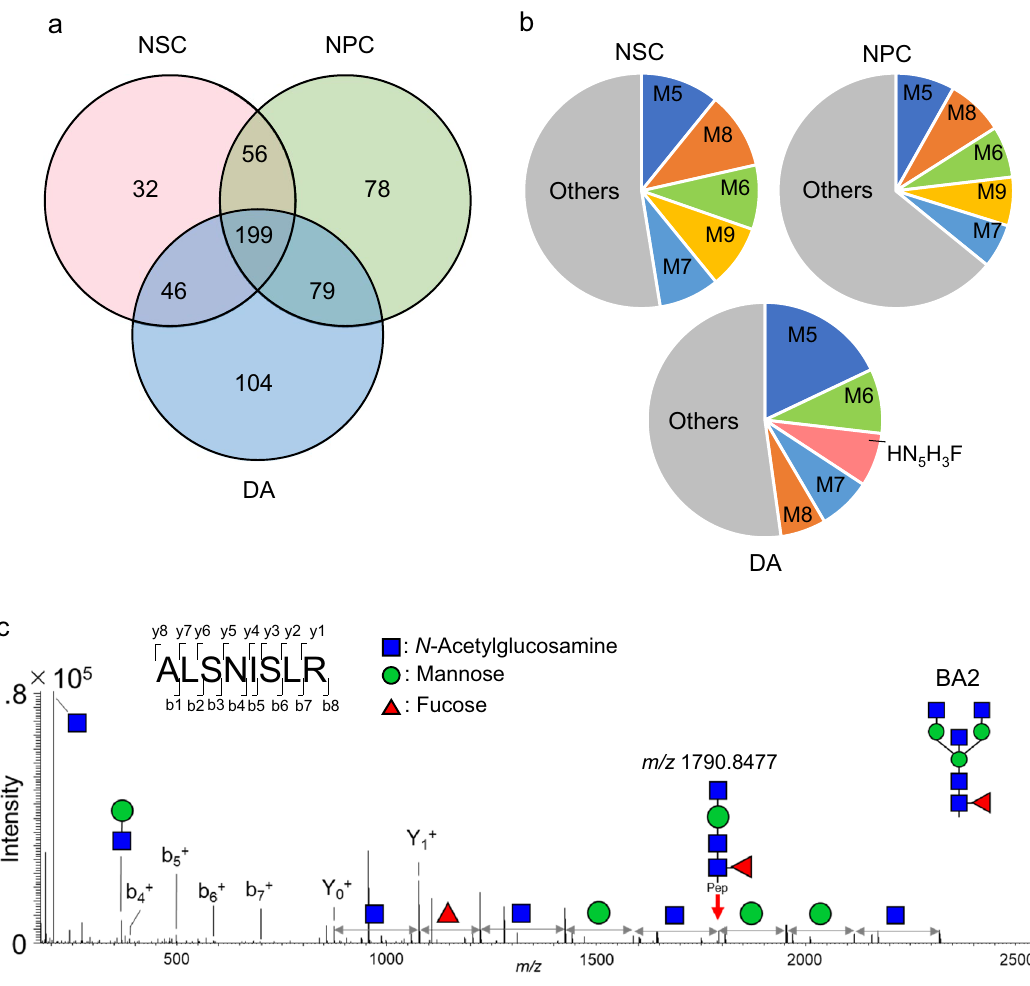
Figure 4. Glycoproteomic dataset of all N-glycosylated peptide glycoforms in the iPSCs, NSCs, NPCs, and DAs. ( a ) The Venn diagram of glycoproteins with increased levels (relative peak area > 2.0, p < 0.05) in NSCs, NPCs, and DAs compared to iPSCs. ( b ) Percentage of increased N-glycan forms (relative peak area > 2.0, p < 0.05) in the NSCs, NPCs, and DAs compared to the iPSCs. ( c ) Product ion spectrum of plexin B2 glycopeptide arising from the precursor ion at m/z 1,261.0690 (charge: 2). The product ion at m/z 1,790.8477 (charge: 1) suggests the presence of bisecting